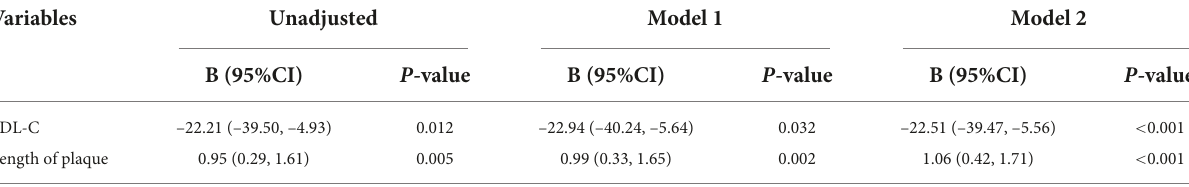
TABLE 6 Multivariate regression analysis of factors influencing the LDL-C reduction rate.